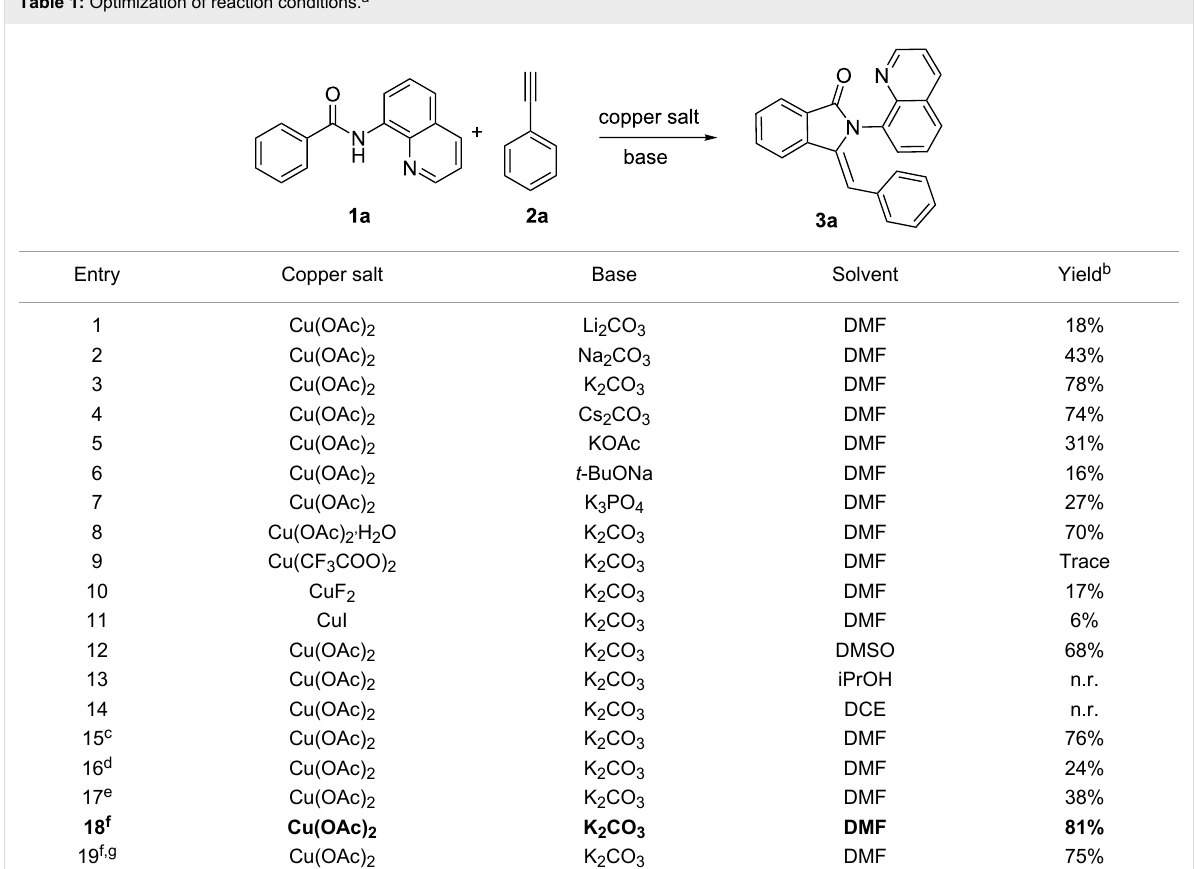
Table 1: Optimization of reaction conditions.